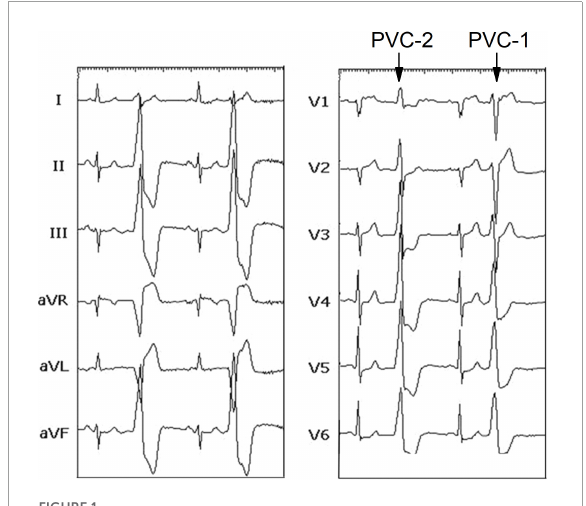
FIGURE1 Twelve lead-ECG recorded before the procedure showing sinus rhythm, PVC-1, and PVC-2. ECG, electrocardiogram; PVC, premature ventricular